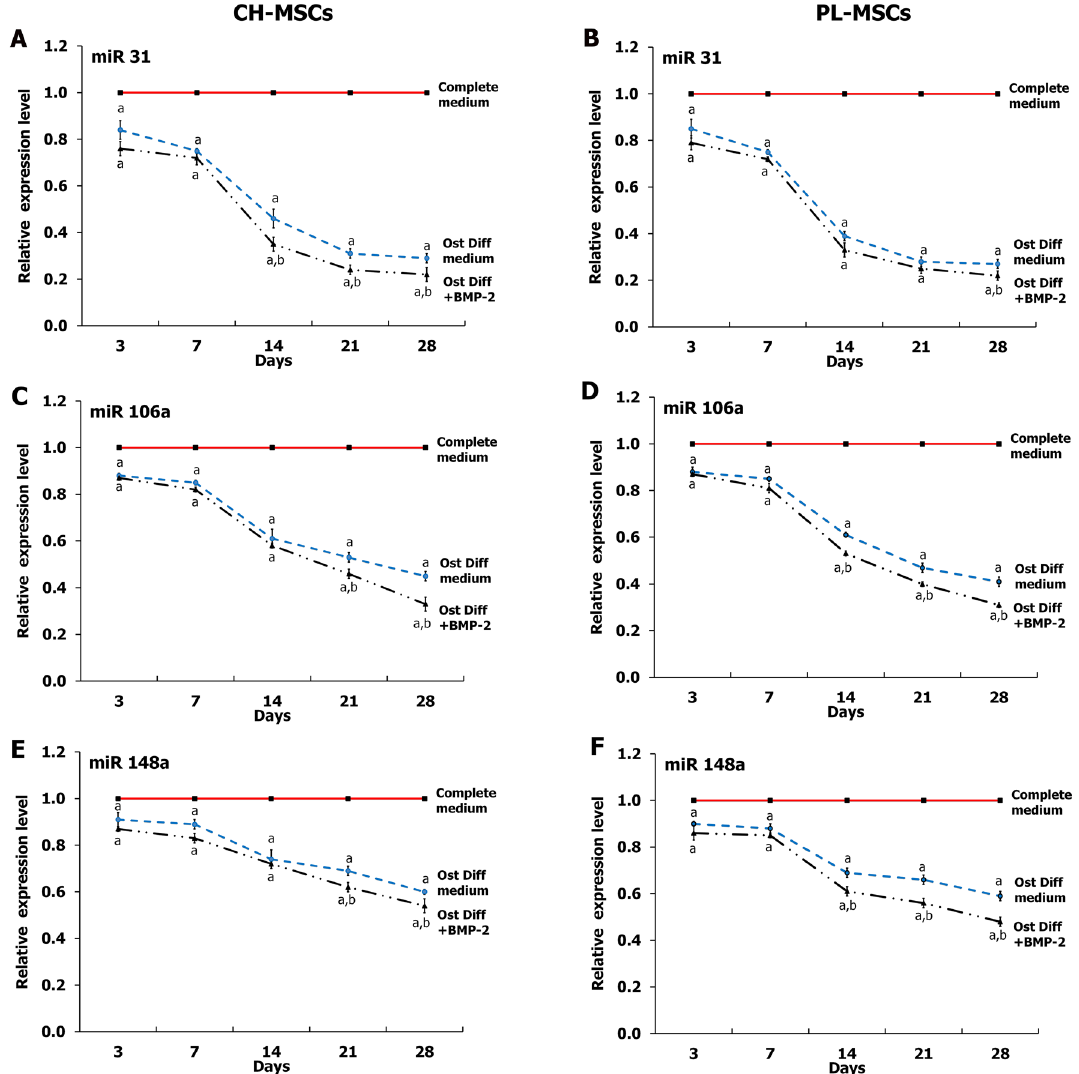
Figure 4. Real-time RT-PCR illustrating the expression of hsa-miR-31, hsa-miR-106a, and hsa-miR-148a during osteogenesis of CH-MSCs ( A , C , E ) and PL-MSCs ( B , D , F ) at the indicated time points. Data were calculated based on averages of 3 samples per each condition. p <0.05 compared to MSCs cultured in complete DMEM medium marked as “a”. p <0.05 compared to MSCs cultured in osteogenic differentiation medium (OstDiff medium) marked as